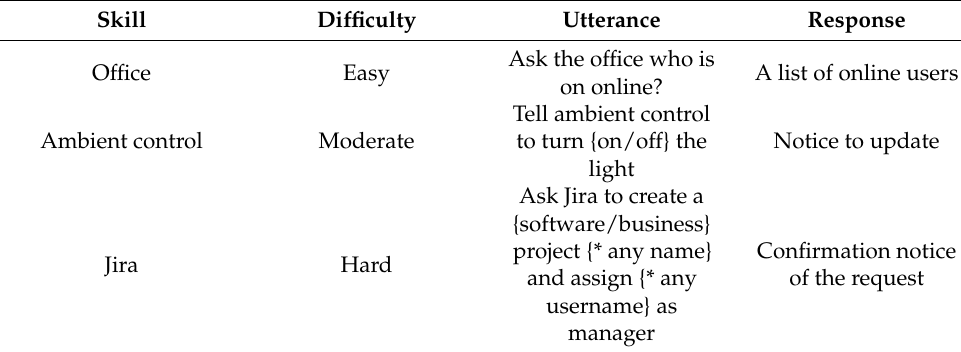
Table 1. Experimental test cases.